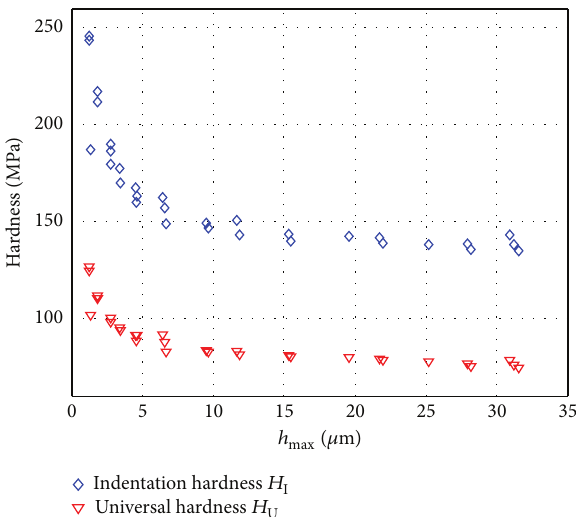
Figure 19: Indentation hardness 𝐻 I and universal hardness 𝐻 U of PAI obtained with a Berkovich tip with a 20 s loading and unloading times (without holding time)